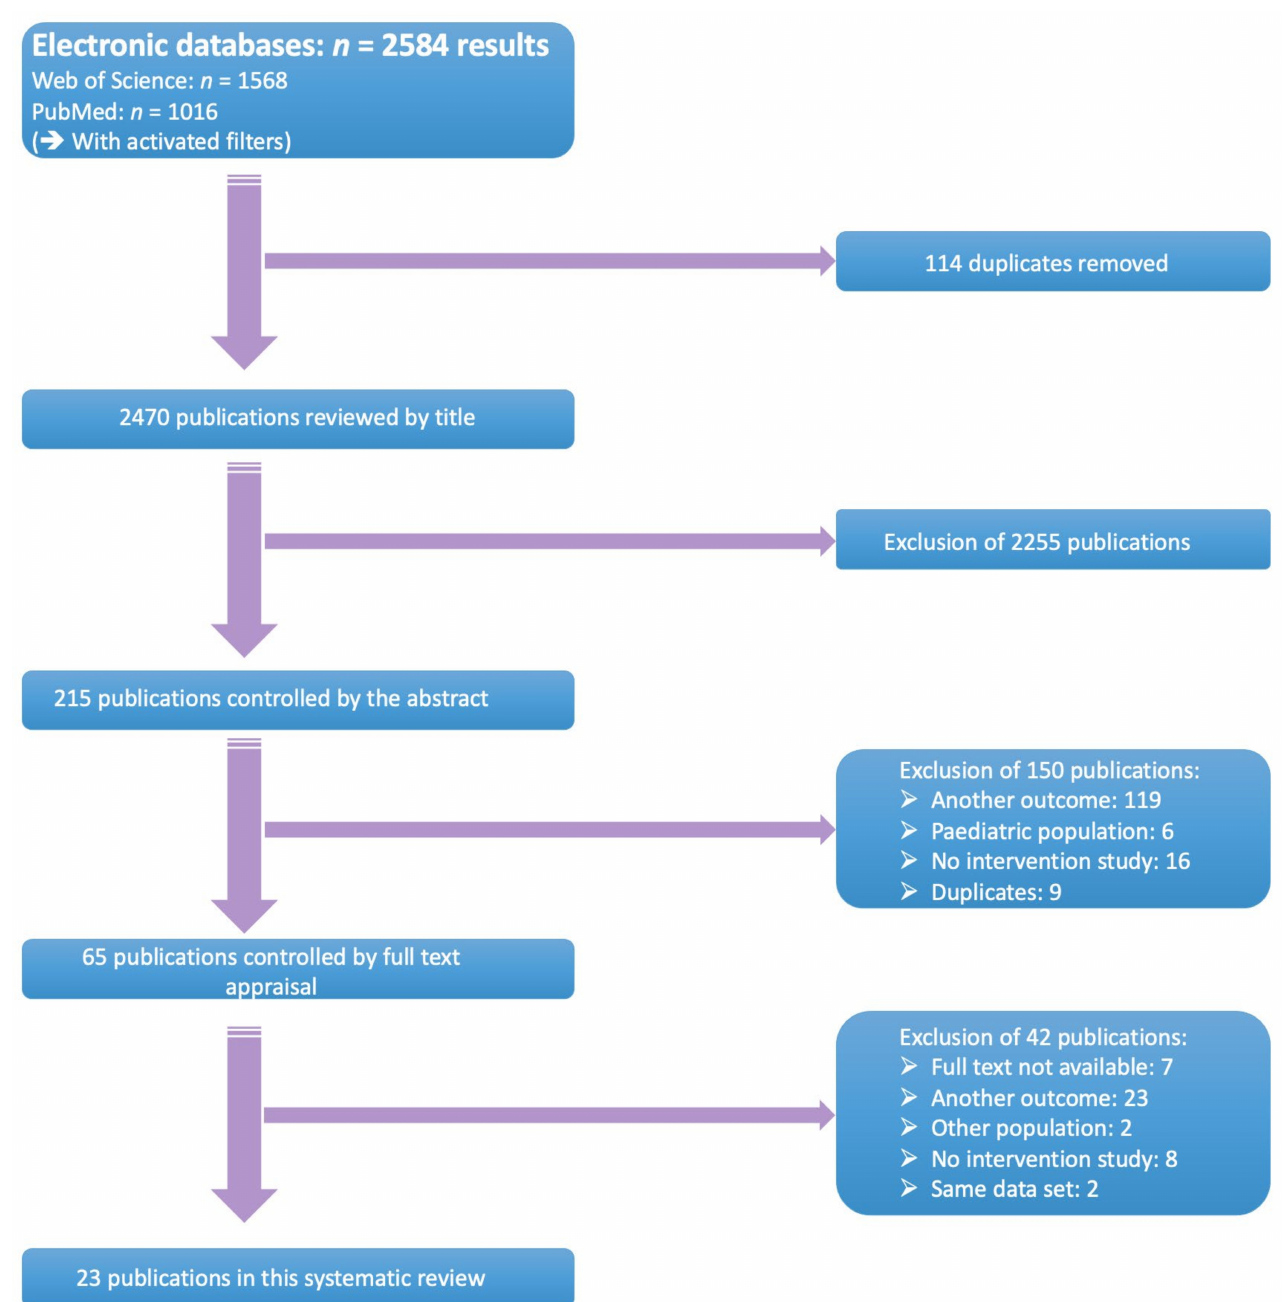
Figure 1. Selection